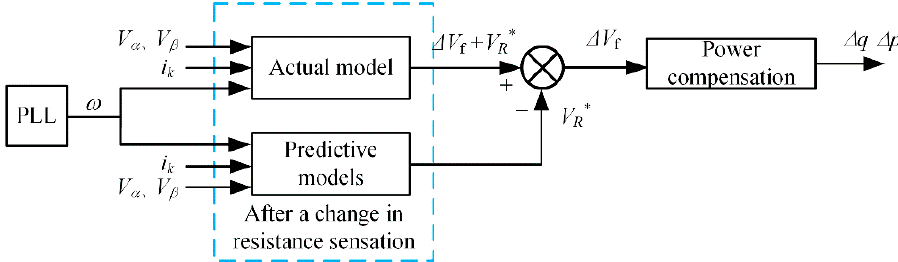
Figure 8. C ontrol block diagram of the proposed power compensation strategy. Figure 8. Control block diagram of the proposed power compensation strategy.